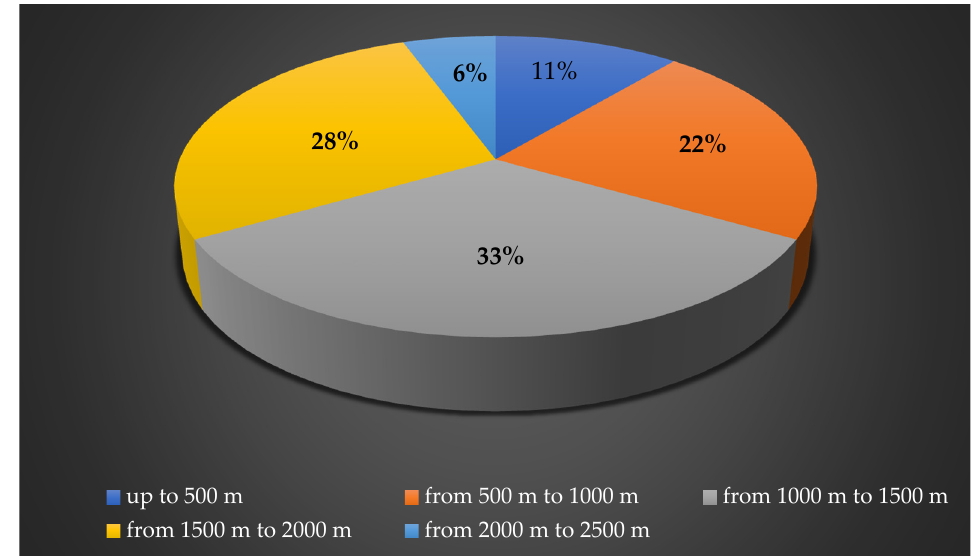
Figure 8. Distribution of injected formation depths (from Table 7).